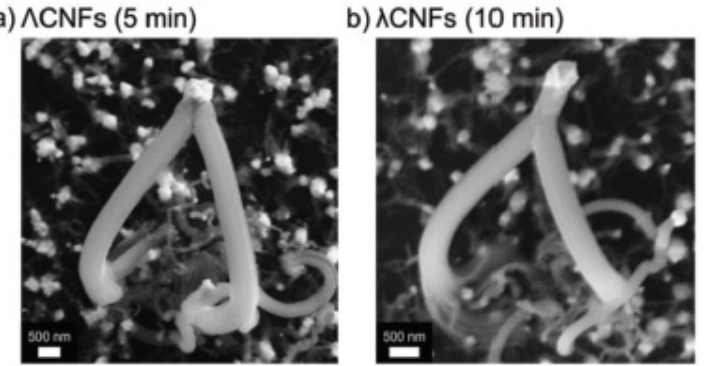
Figure 11. ( a ) SEM images of Λ CNF after growth times of 5 min. ( b ) Increasing the growth time leads to λ CNFs. These samples grow after 10 min. The catalytic centers are visible as bright parti- cles at the ends of the lambda-shaped CNFs and consist presumably of nickel. Reproduced with